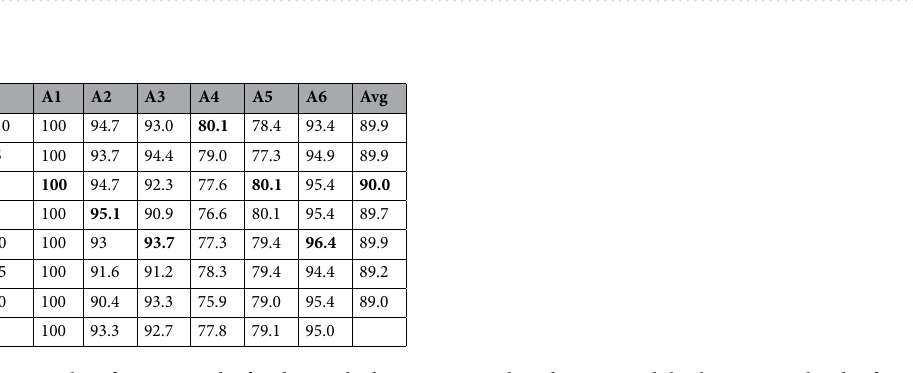
Table 10. Classification results for the masked spectrogram data domain, with both patent and radar features and different threshold values.